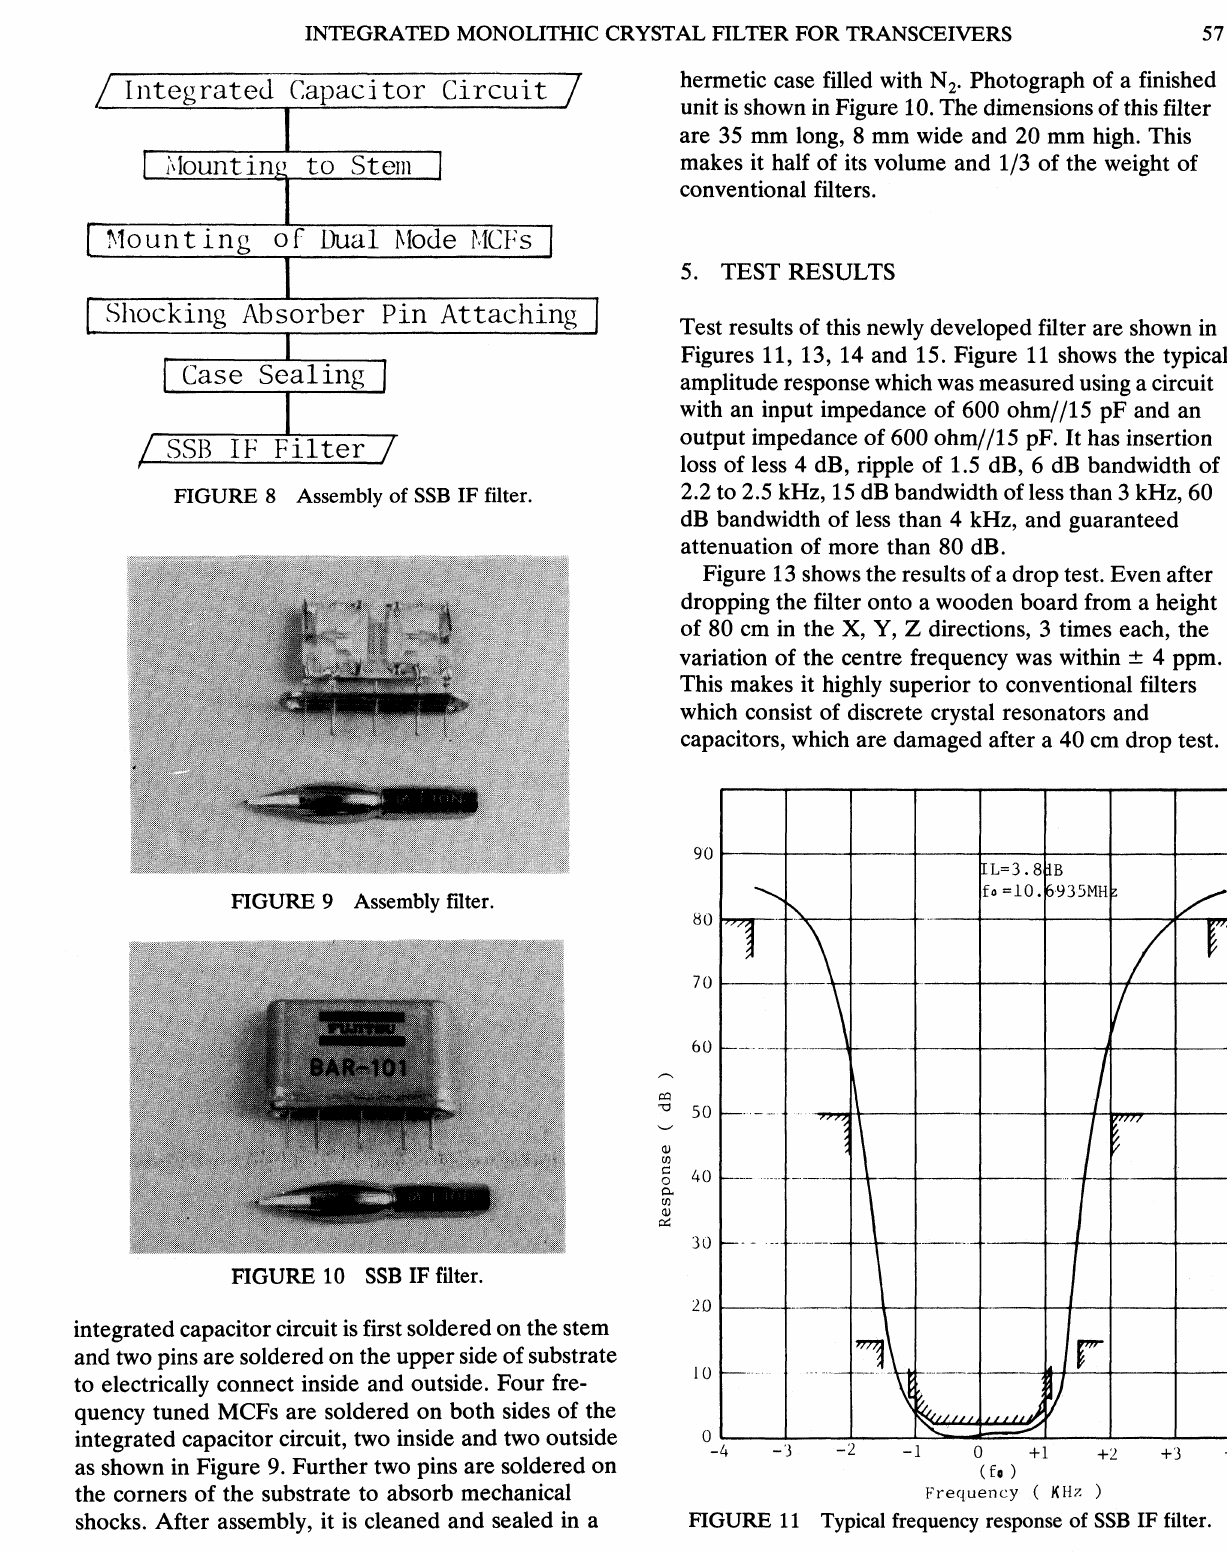
FIGURE 11 Typical frequency response of SSB IF